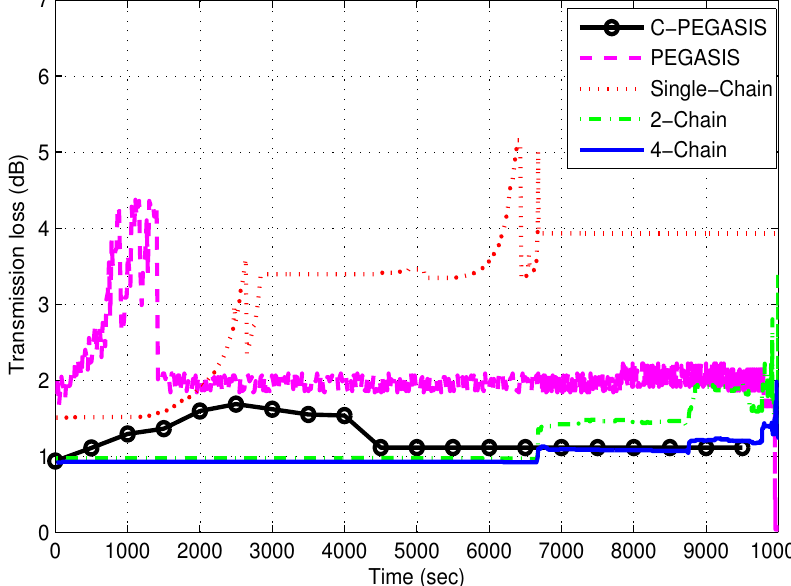
Figure 10. Transmission loss (dB) in 4-chain, 2-chain, single chain-based routing and